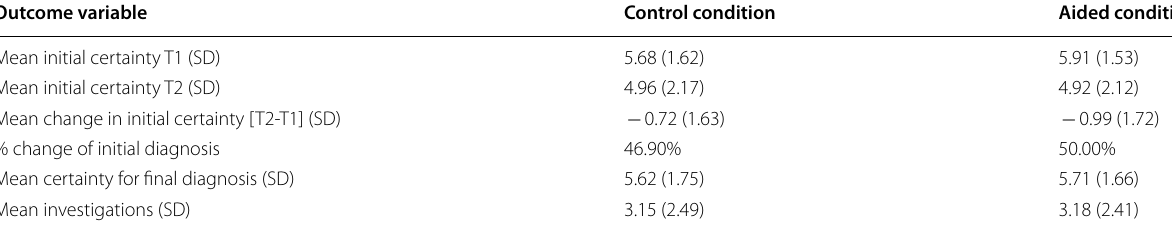
Change in initial certainty refers to the difference between the second (T2) and first (T1) measurements of initial certainty; on average, values were negative, indicating a reduction in certainty after participants saw the additional patient information at step 2